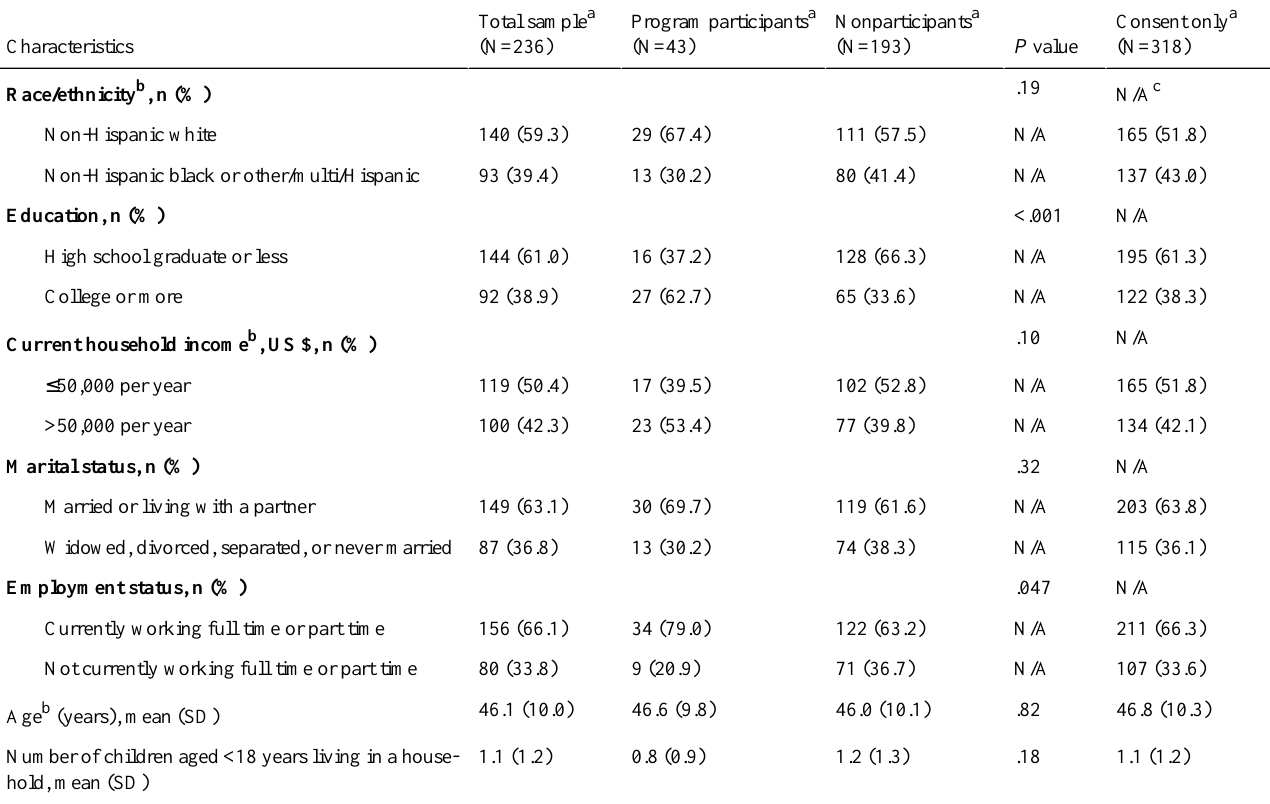
Table 1. Baseline demographic characteristics of the sample by program participation, Louisiana, 2017 to